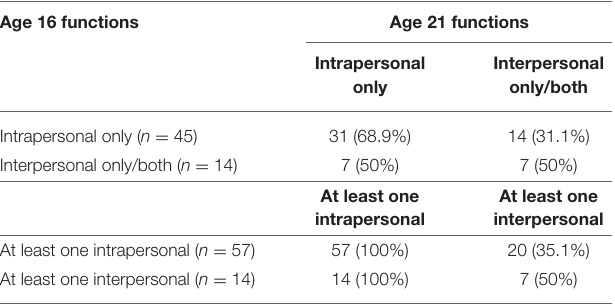
TABLE 2 | Proportions of Intrapersonal and Interpersonal NSSH functions at age 16 and